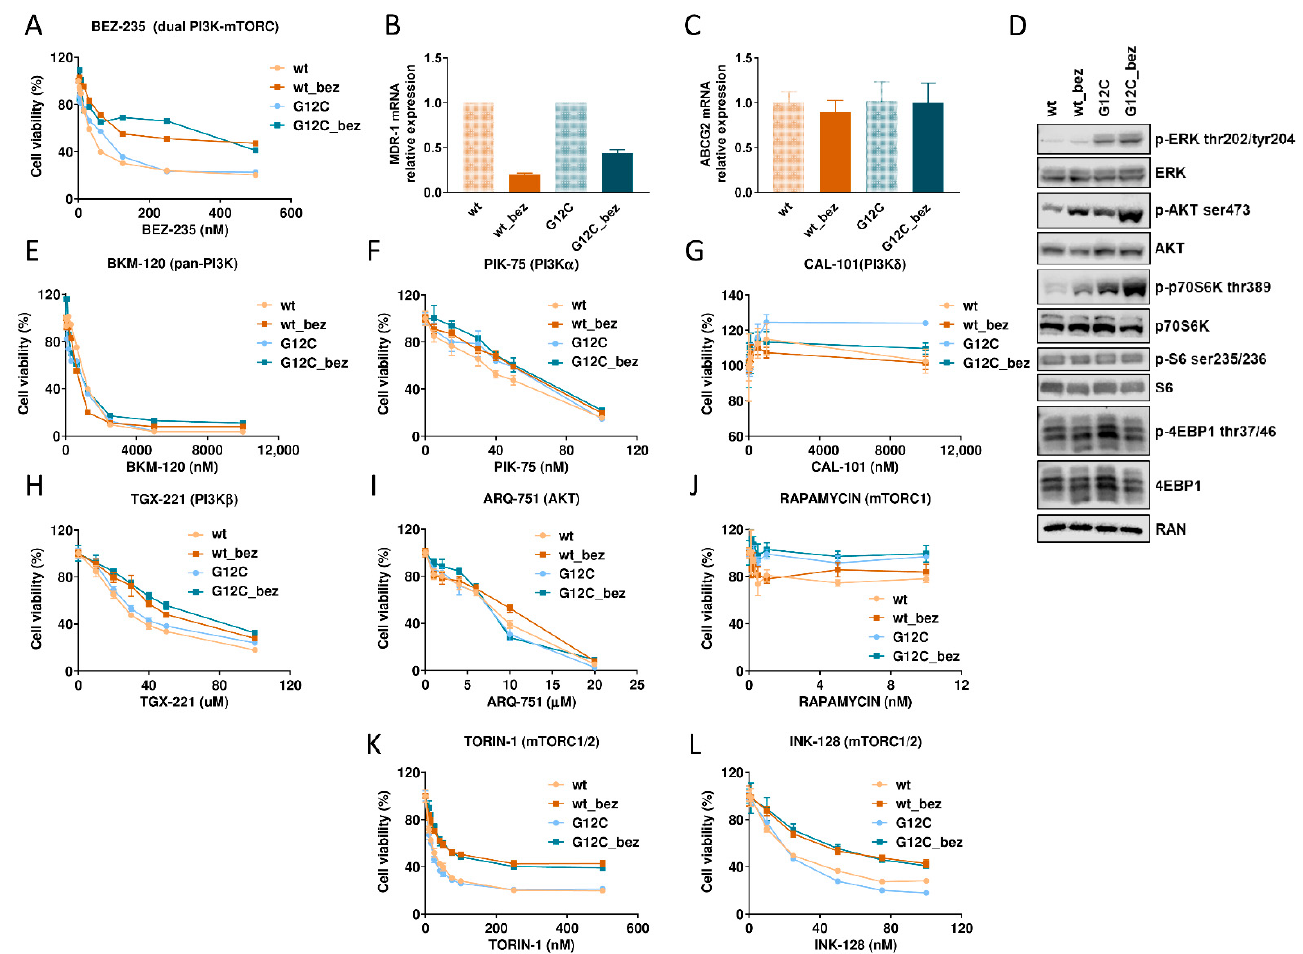
Figure 1. ( A ) Dose-response curve of the clones treated with BEZ235 at different concentrations. The means and standard deviation (SD) of at least three independent experiments are plotted. Statistical analysis was carried out through the two-way ANOVA test and the Bonferroni post hoc test for multiple comparisons and is reported in Supplemental Table S3. ( B ) Histograms representing the relative expression of MDR-1 mRNA levels. Actin was used as a housekeeping gene for normalization. The means of three replicates and SD are reported. ( C ) Histograms representing the relative expression of ABCG2 mRNA levels. Actin was used as a housekeeping gene for normalization. The means of three replicates and SD are reported. ( D ) Western blot analysis of MAPK and PI3K/mTOR pathway proteins in wt, wt_bez, G12C and G12C_bez clones at basal conditions. Ran was used as a loading control. ( E – L ) Dose-response curves of the clones treated with PI3K/Akt/mTOR inhibitors at increasing concentrations. On each graph, the specific drug with the corresponding target is reported. The means and standard deviation (SD) of at least three independent experiments are plotted.